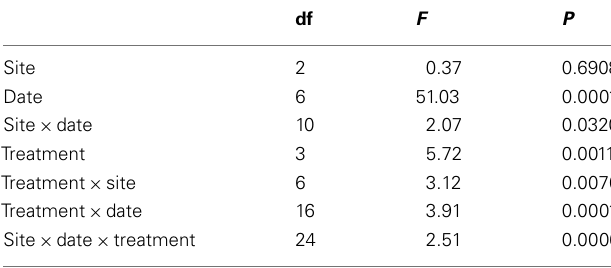
Table 2 |Analysis of variance for rates of CH 4